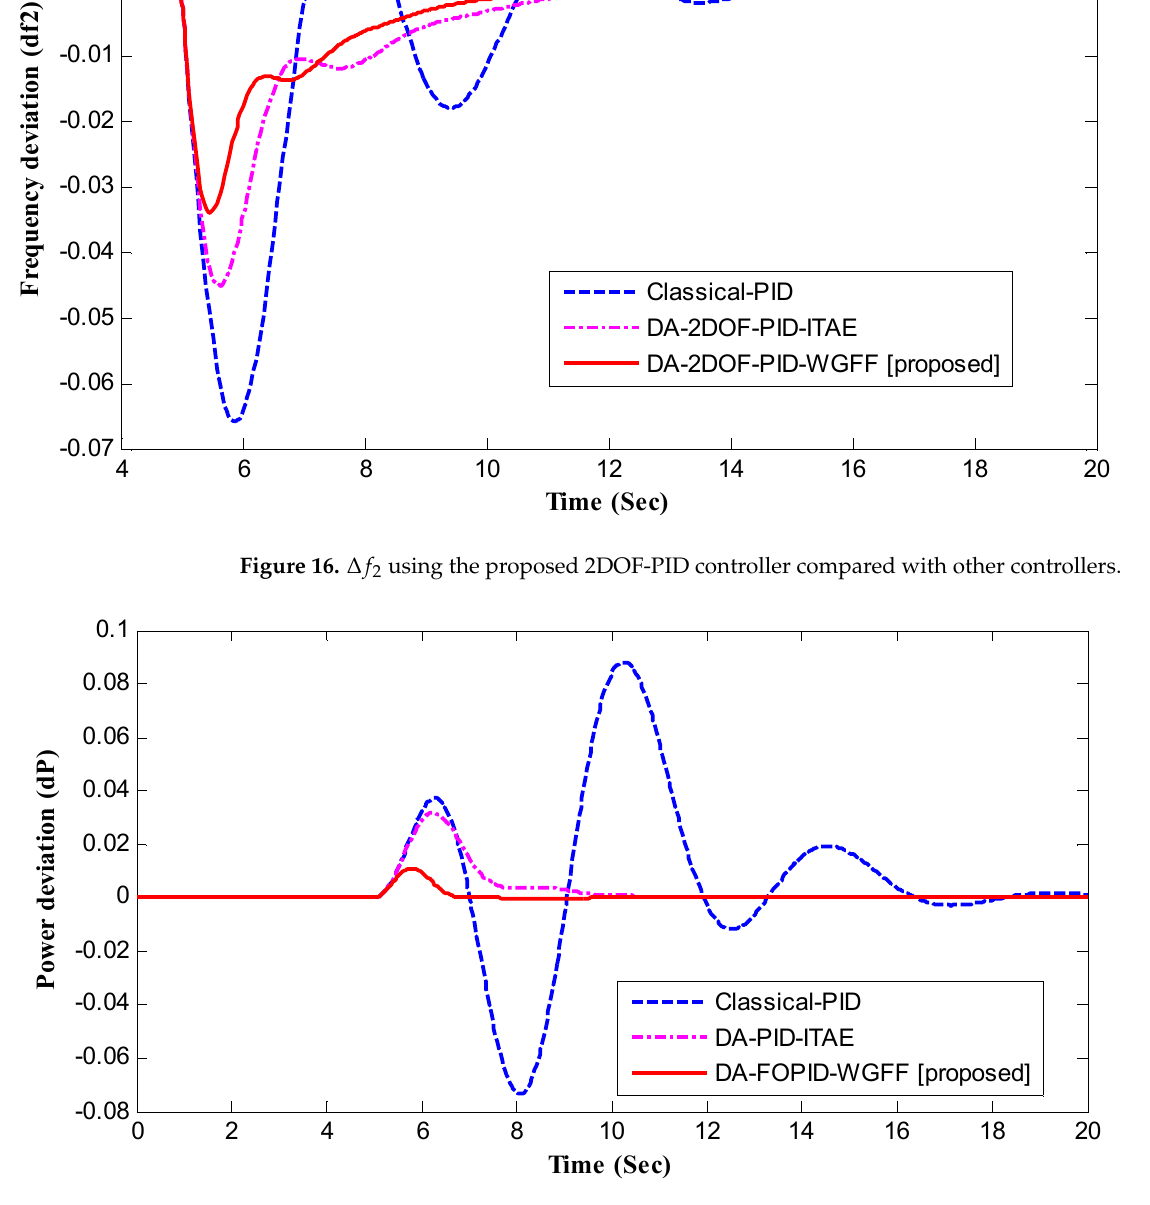
Figure 17. Δ P using the proposed 2DOF-PID controller compared with other controllers. Figure 17. ∆ P using the proposed 2DOF-PID controller compared with other